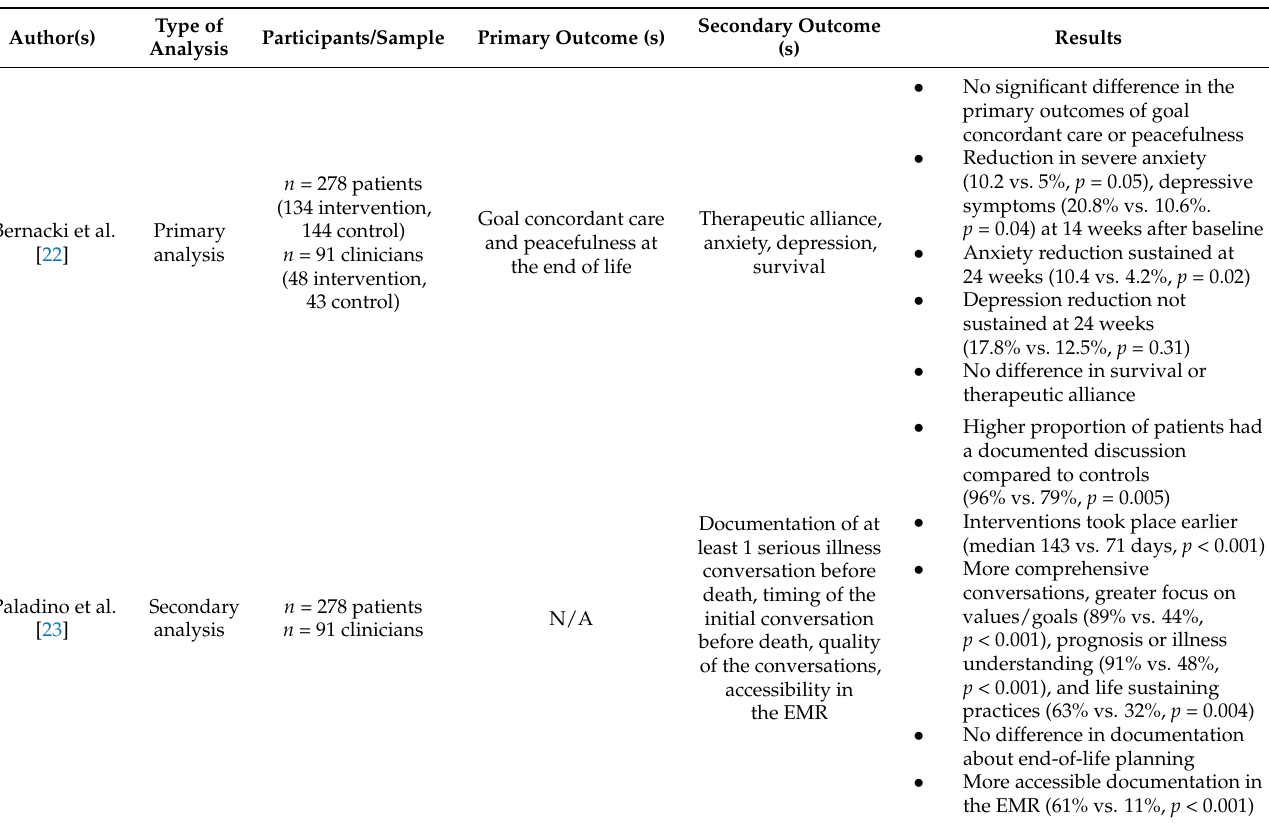
Table 1. Published studies (primary and secondary analyses) of the Cluster Randomized Trial of the Serious Illness Care Program in